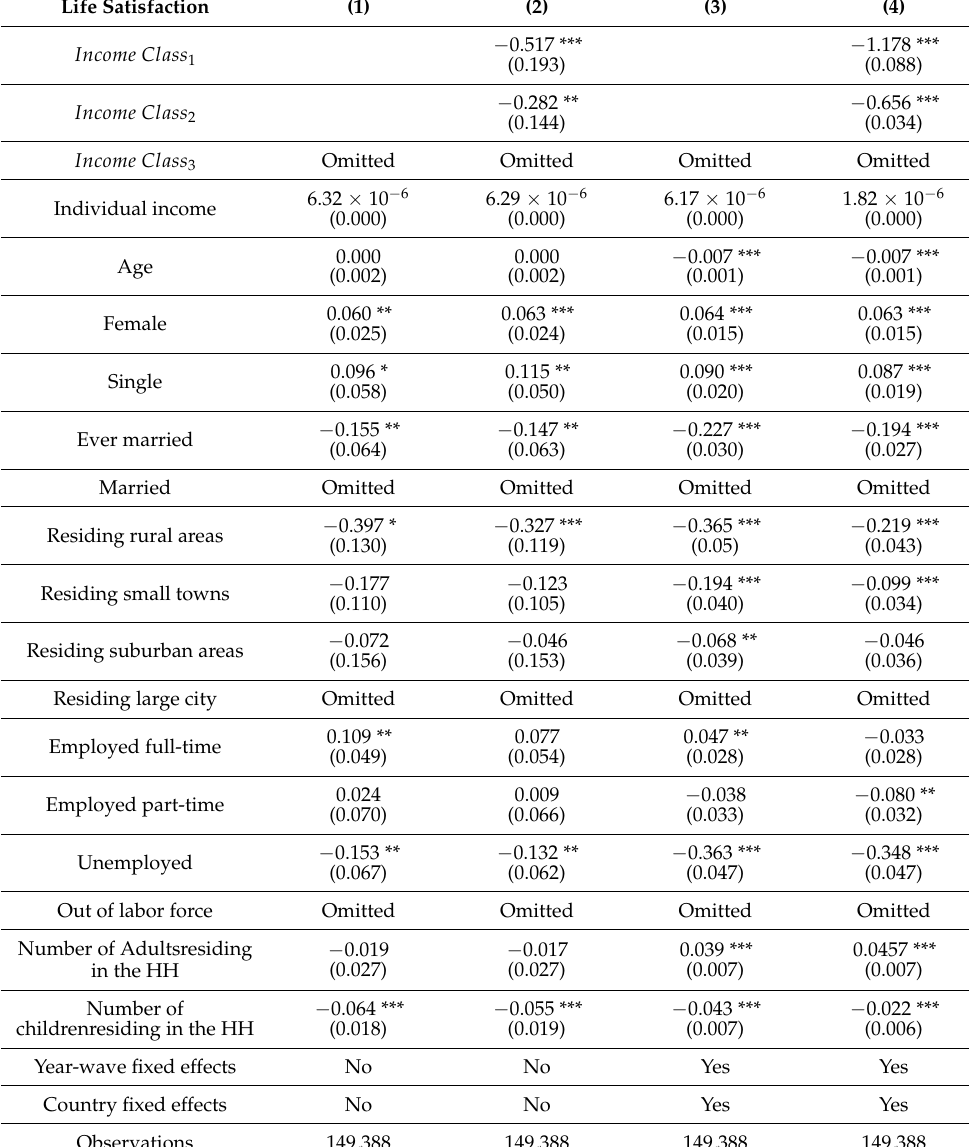
Table A3. Robustness analysis: income and asset